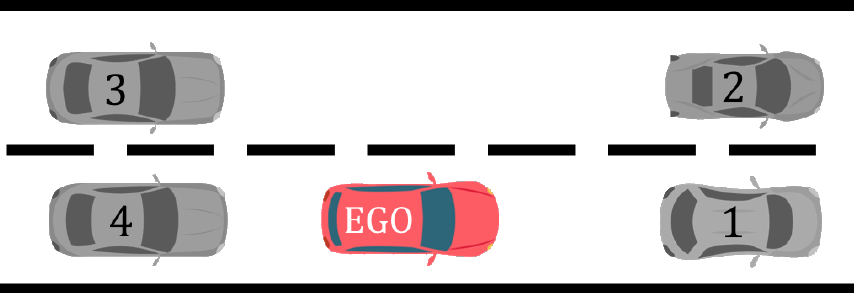
Figure 4. Road configuration with the surrounding vehicles before the maneuver (red: ego-vehicle).